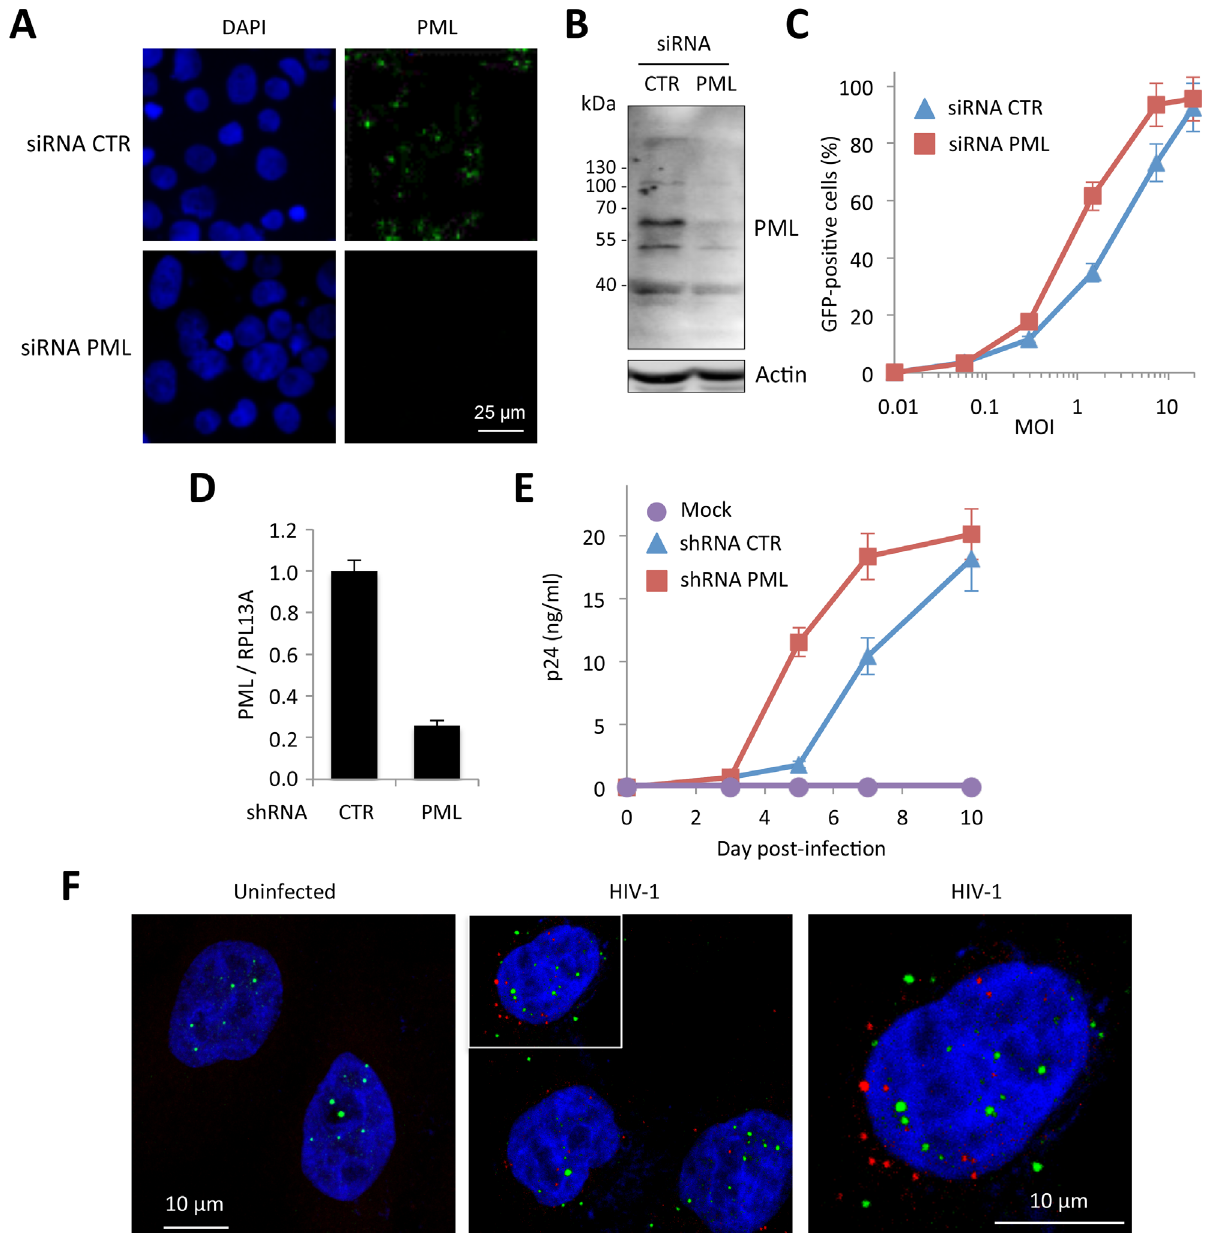
Fig 1. PML expression in human cells interferes with HIV infection. (A and B) HeLa cells were transfected with siRNA directed against all PML isoforms or a non-targeting siRNA (CTR). Knockdown efficiency was estimated by immunofluorescence (A) and Western-blot (B). (C) Cells were then infected with VSV-G pseudotyped HIV-1 vector expressing GFP at increasing MOI during 48h and the percentage of GFP expressing cells was determined by flow cytometry. The graph shows means +/- SD of 3 independent experiments performed in duplicates (D and E) PBMCs of healthy adult individuals were activated by anti-CD3/anti-CD28 for 48 h and were subsequently transduced with a lentiviral vector expressing either a non-targeting control (CTR) or a PML- specific shRNA. (D) Relative expression of PML was estimated by RT-qPCR analyis performed on PBMCs two days post-transduction, and expressed as a ratio to RPL13A mRNA expression. (E) Two days post transduction with the shRNA-expressing vector, activated PBMCs were infected with HIV-1 NL4.3 at a dose corresponding to 0.1 ng of p24 and virus production was measured at given time points by measuring the amount of HIV-1 p24 by ELISA on the culture supernatants. Results show the mean of triplicates +/- SD and are representative of two independent experiments. (F) HeLa wt cells were transduced at MOI 10 with HIV-1 derived vector during 4 h and PML (in green) and HIV-1 p24 (in red) were detected by immunofluorescence.